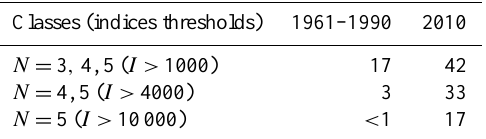
Table 1. Day number with different Nesterov’s classes of flamma- bility in typical conditions for the WMO standard period 1961– 1990 and in fire conditions during July–August 2010 period. Total day number for July–August period is 62. Meteorological Observa- tory of Moscow State University.